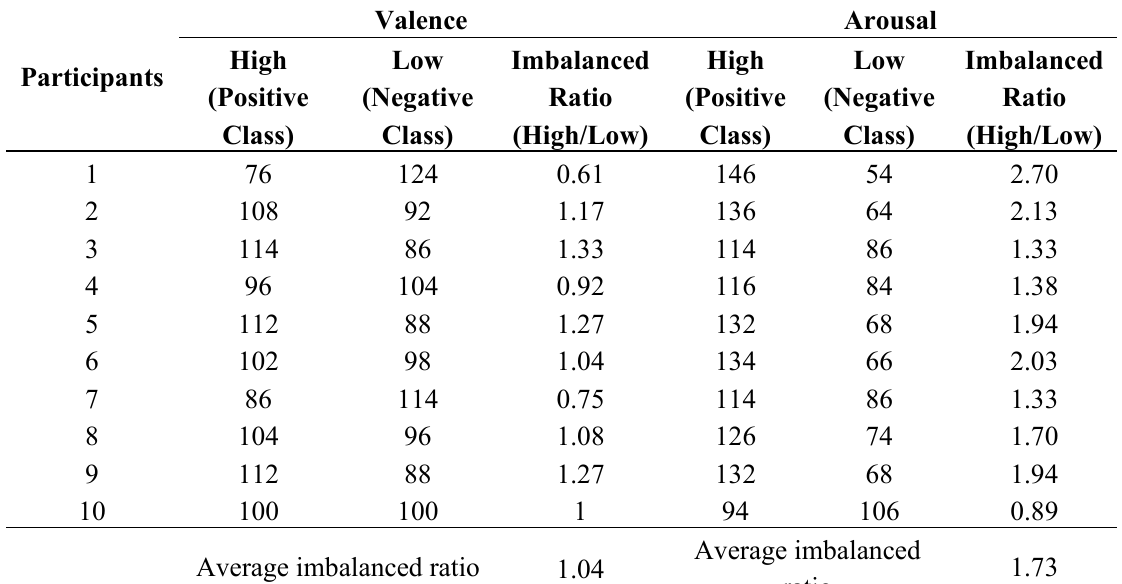
Table 1. EEG data labeling results for the ten